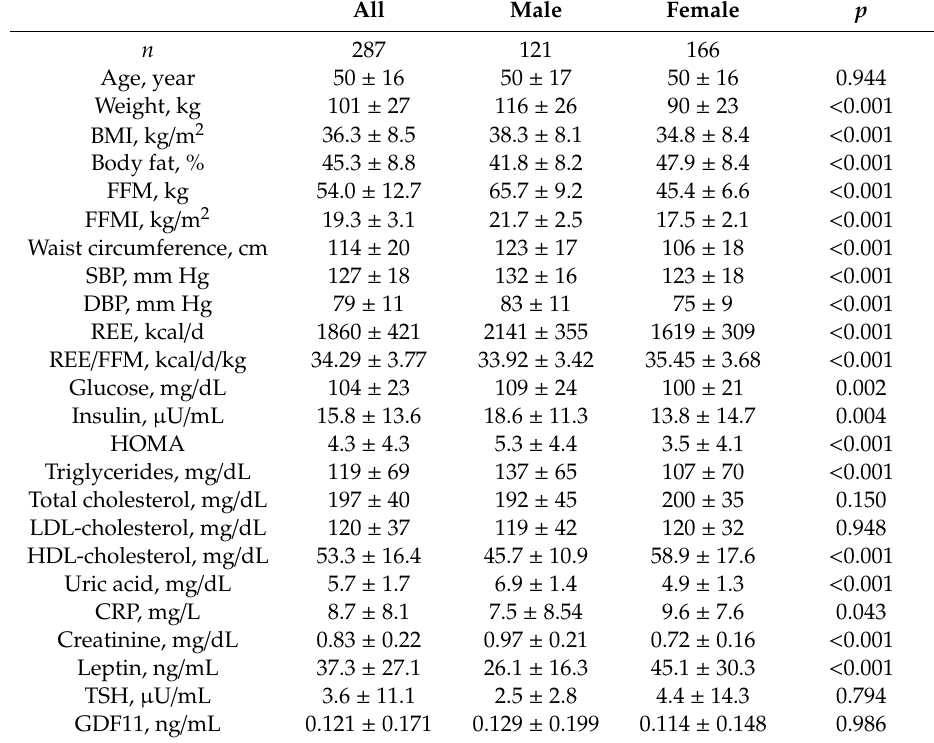
Table 1. Demographic, biochemical, and metabolic characteristics of the individuals included in the overall